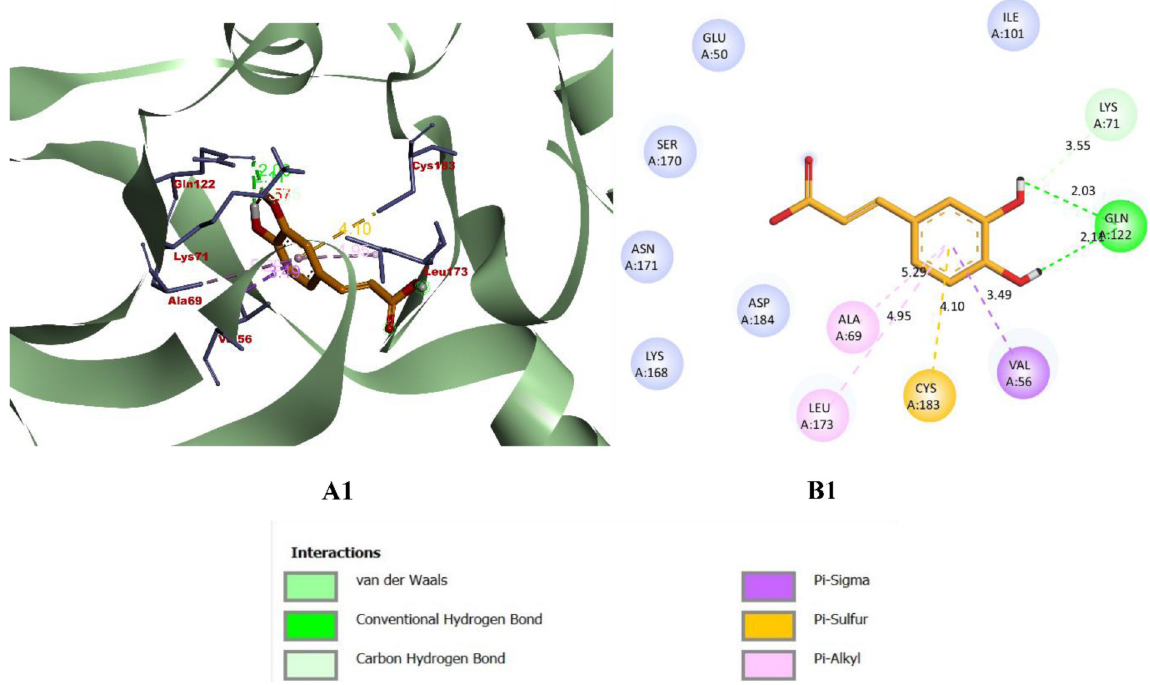
Fig 8. Arrangement (A1) and binding pattern (B1) of binding interactions of caffeic acid from JME with the residues of human MAPK3 protein.